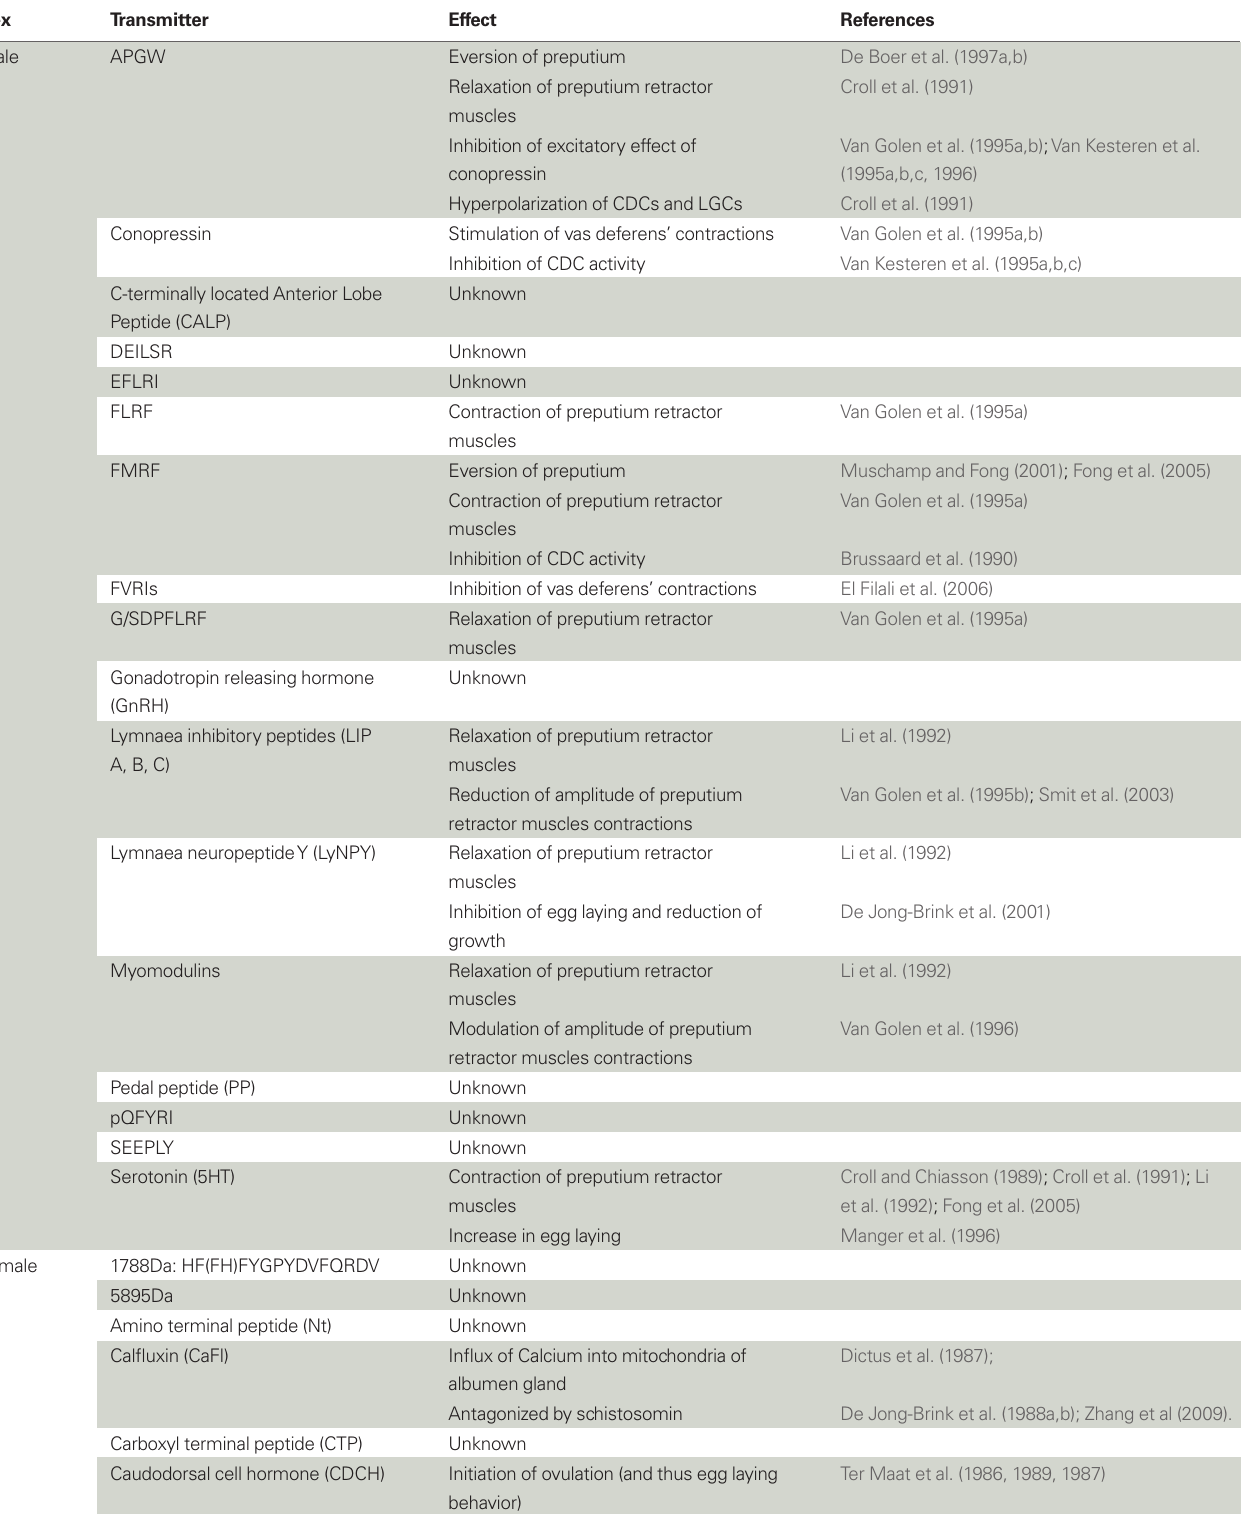
Table 3 | effects of the neuro-endocrine substances involved in male and female reproduction of hermaphroditic freshwater snails.